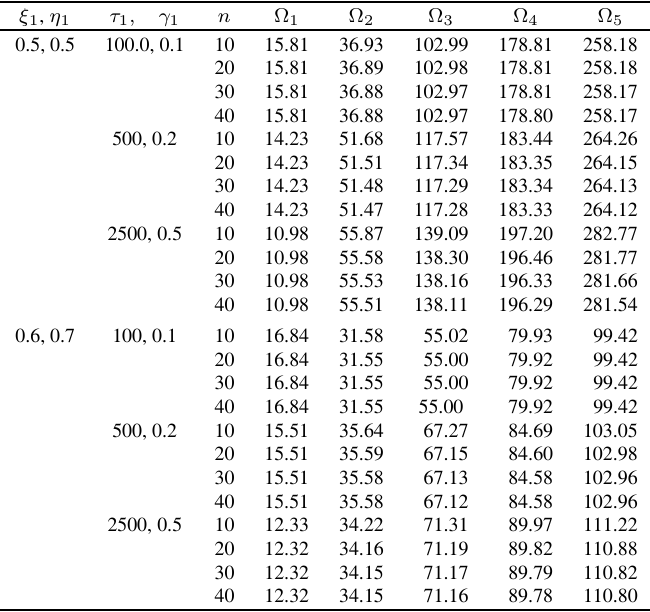
Table 1 The convergence study of the fi rst fi ve coupled eigenfrequencies for a SSSS square plate with one sprung mass in respect to the number of terms ( n )